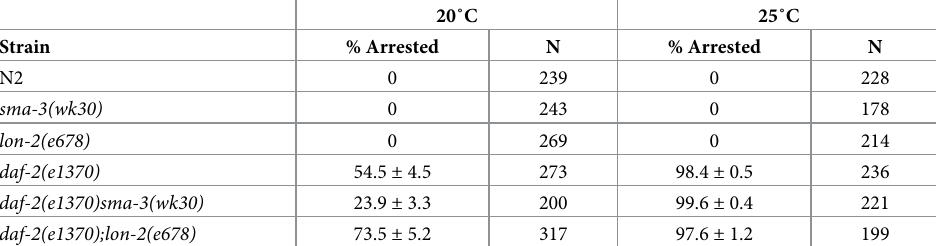
Table 1. DBL-1 Pathway Modulates Dauer Constitutive Phenotype of daf-2 Mutants at 20˚C. In an otherwise wild-type background, DBL-1 signaling exerts no visible effect on dauer induction at both 20˚C and 25˚C. However, in a DAF-2-sensitized background, DBL-1 signaling promotes dauer arrest at 20˚C. This effect is lost when observed at 25˚C, where the loss of DAF-2 signaling is most potent. Values given are percent arrested dauer-like larvae of total progeny ±